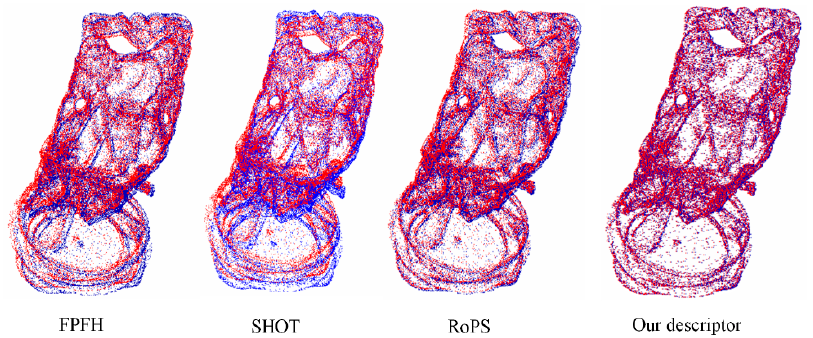
Figure 10. Comparison Happy Buddha registration result based on four descriptors. From left to right is the result of FPFH, SHOT, RoPS and our descriptor respectively. The source point cloud is shown in blue, and the target point cloud is shown in red.